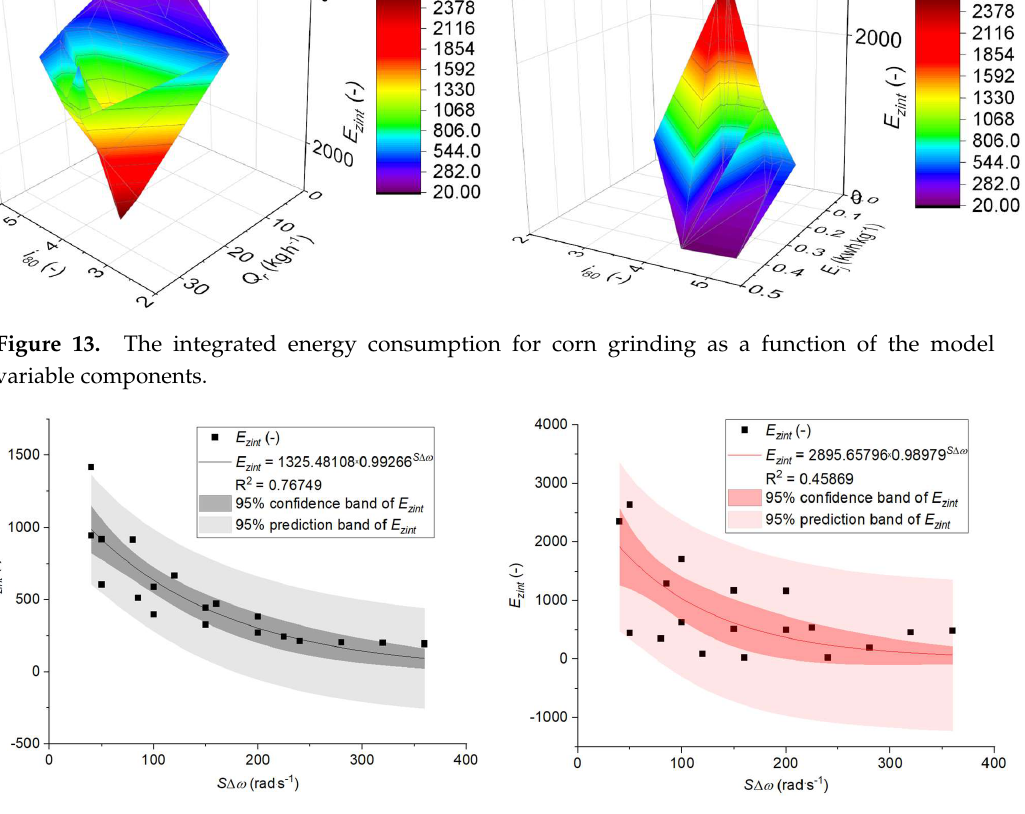
Table 11. Results of the significance tests for the equations of the integrated energy consumption regression.